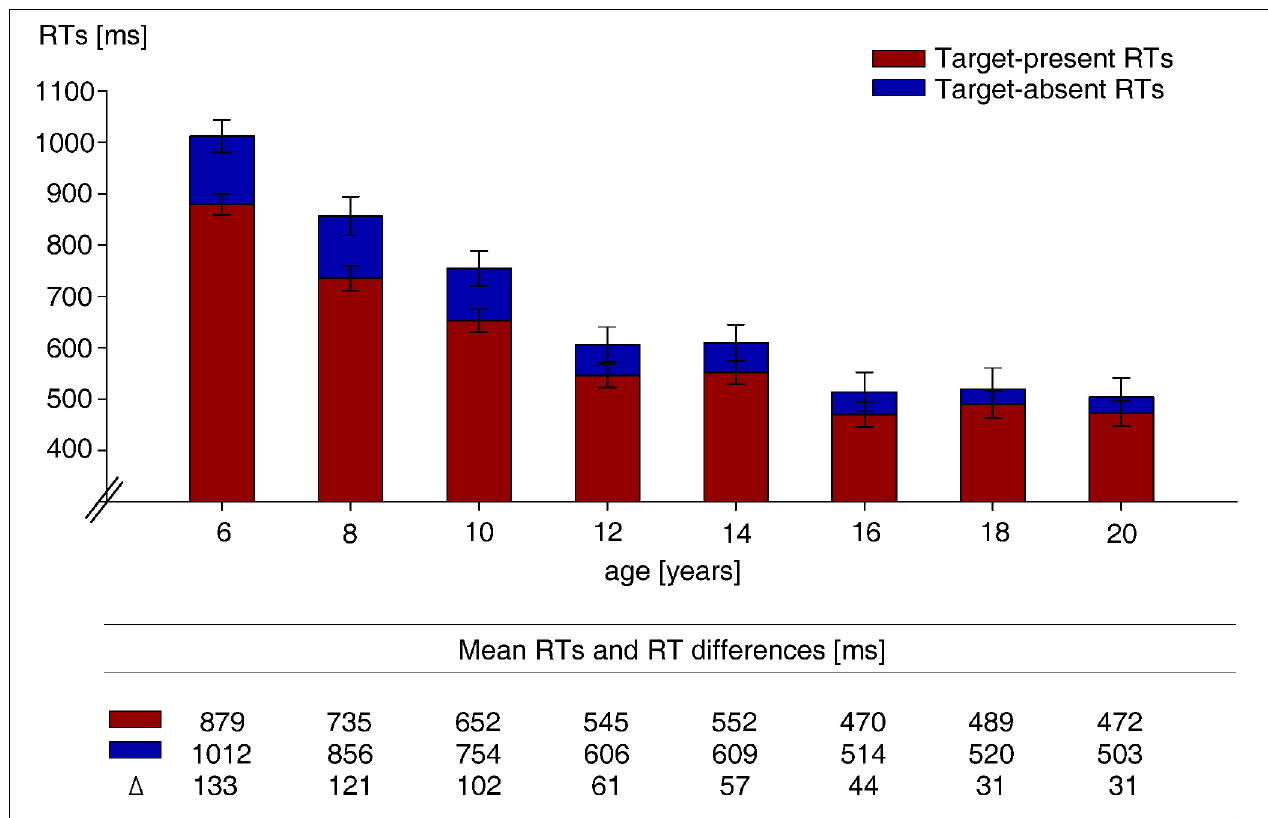
FIGURE 3 | Mean search RTs on target-absent trials of the visual search task, and mean RT differences between target-absent and -present trials. All RTs are measured in milliseconds. Error bars reflect standard error of the mean.